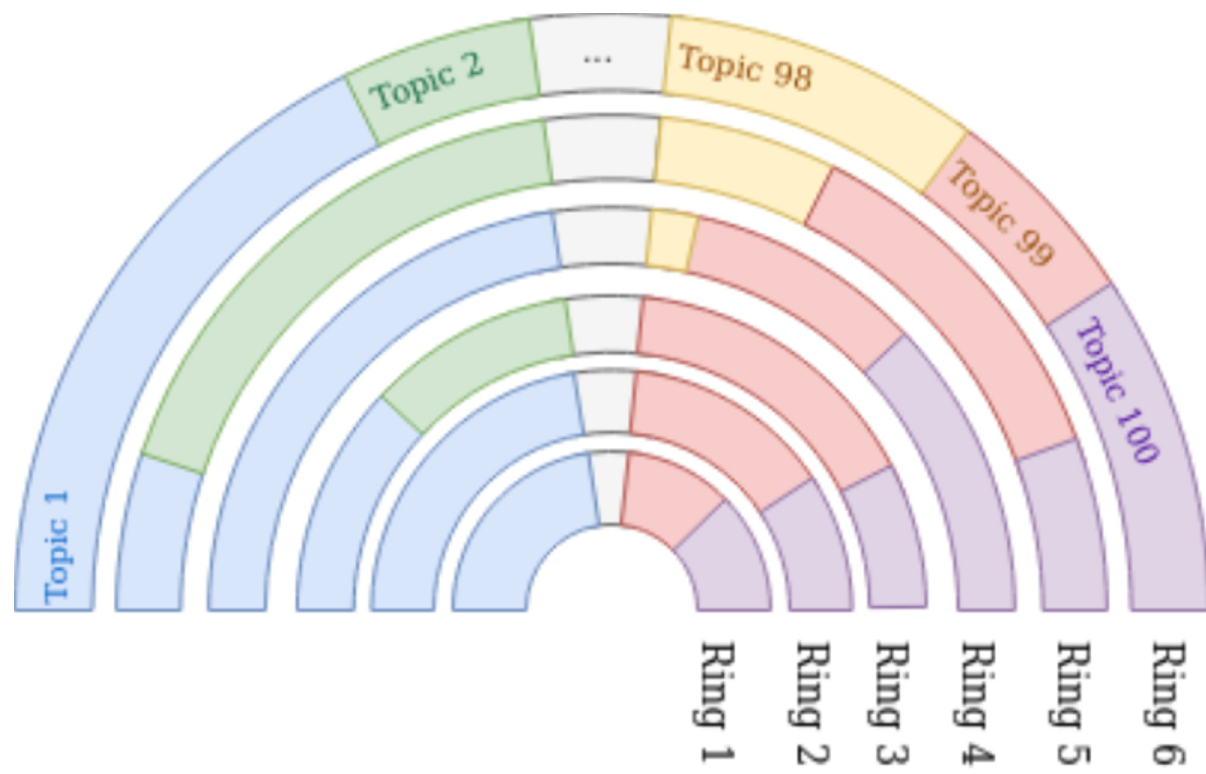
Fig 10. Number of topics vs. average topic similarity. The threshold of one hundred topics is marked with the dashed red line. This threshold is situated at the end of the bend for specialized datasets, and in the middle of the bend for both random datasets.